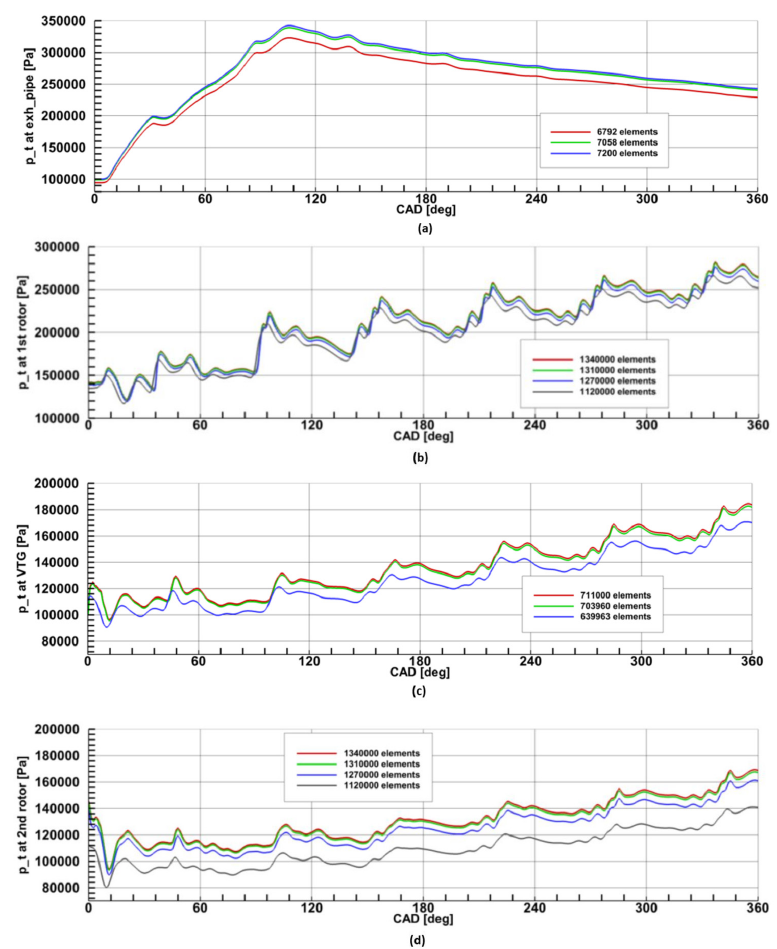
Figure 7. The mass-average pressure changes during the single revolution of the crankshaft for different mesh density on: ( a ) exhaust pipe, ( b ) 1st stage rotor, ( c ) VTG vanes, ( d ) 2nd stage rotor [29].